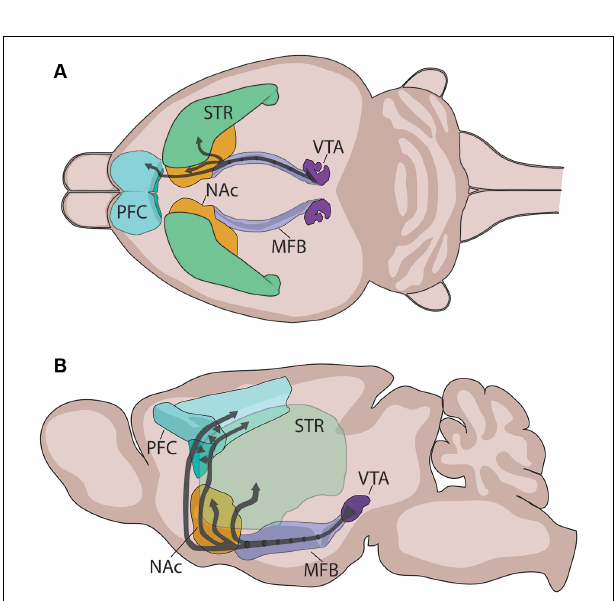
FIGURE 1 | Adolescence and Puberty timing in humans and rodents. (A) Timeline of adolescence (shaded lines) and puberty (darker portions of the lines) in girls ( and boys ( ), adapted from Hollenstein and Lougheed (2013), Sawyer et al. (2018), and Brix et al. (2019). (B) Adolescence (shaded lines) and puberty (darker portions of the lines) timing in female ( ) and male ( ) rodents, adapted from Vetter-O’Hagen and Spear (2012) and Schneider (2013). ♂ ♀ ♂